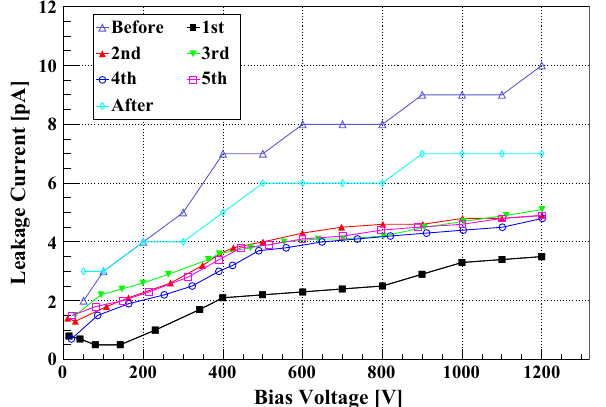
Fig. 9 Leakage current of detector USD-8-4-15 as a function of its bias voltage in various environments. The numbers in the legend denote thermal cycles in LN 2 . The scale for the first cycle in LN 2 and the LAr measurement is on the right